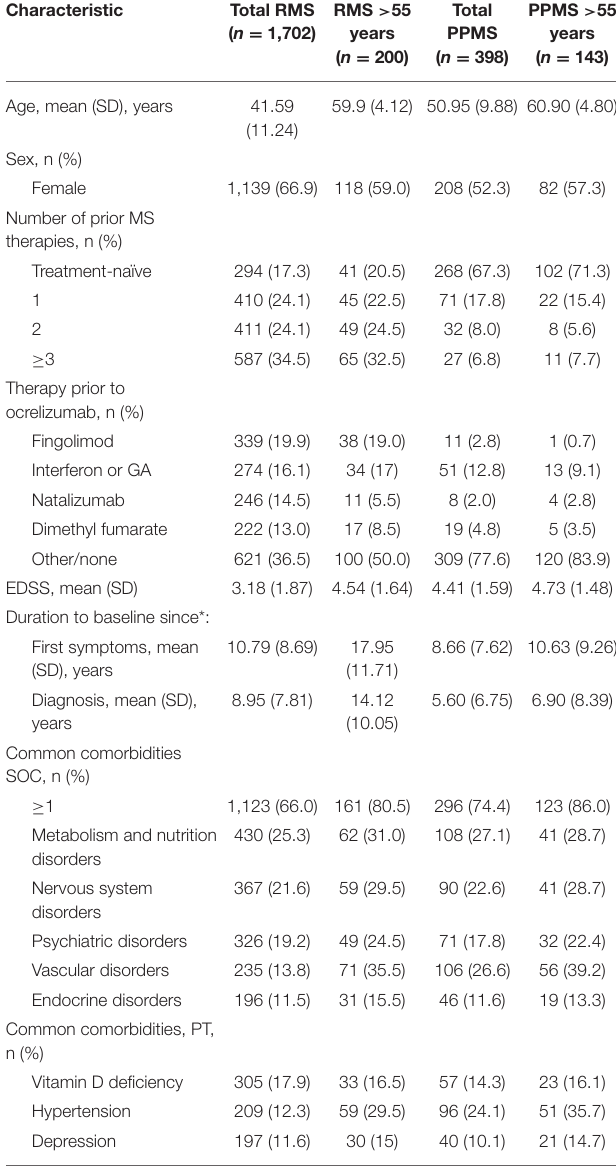
TABLE 1 | Baseline characteristics (safety